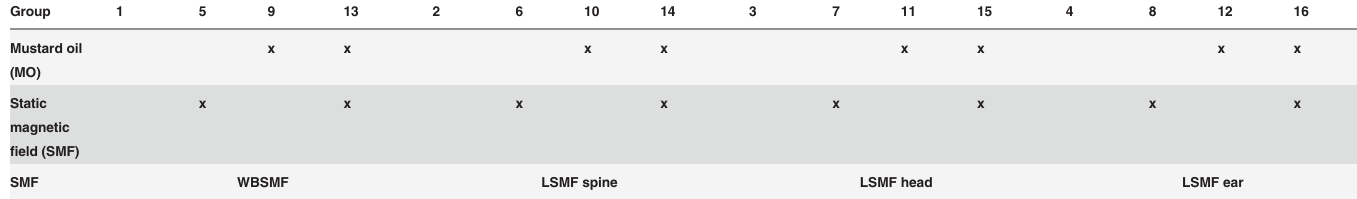
Table 1. Relationship between the animal groups and the treatment